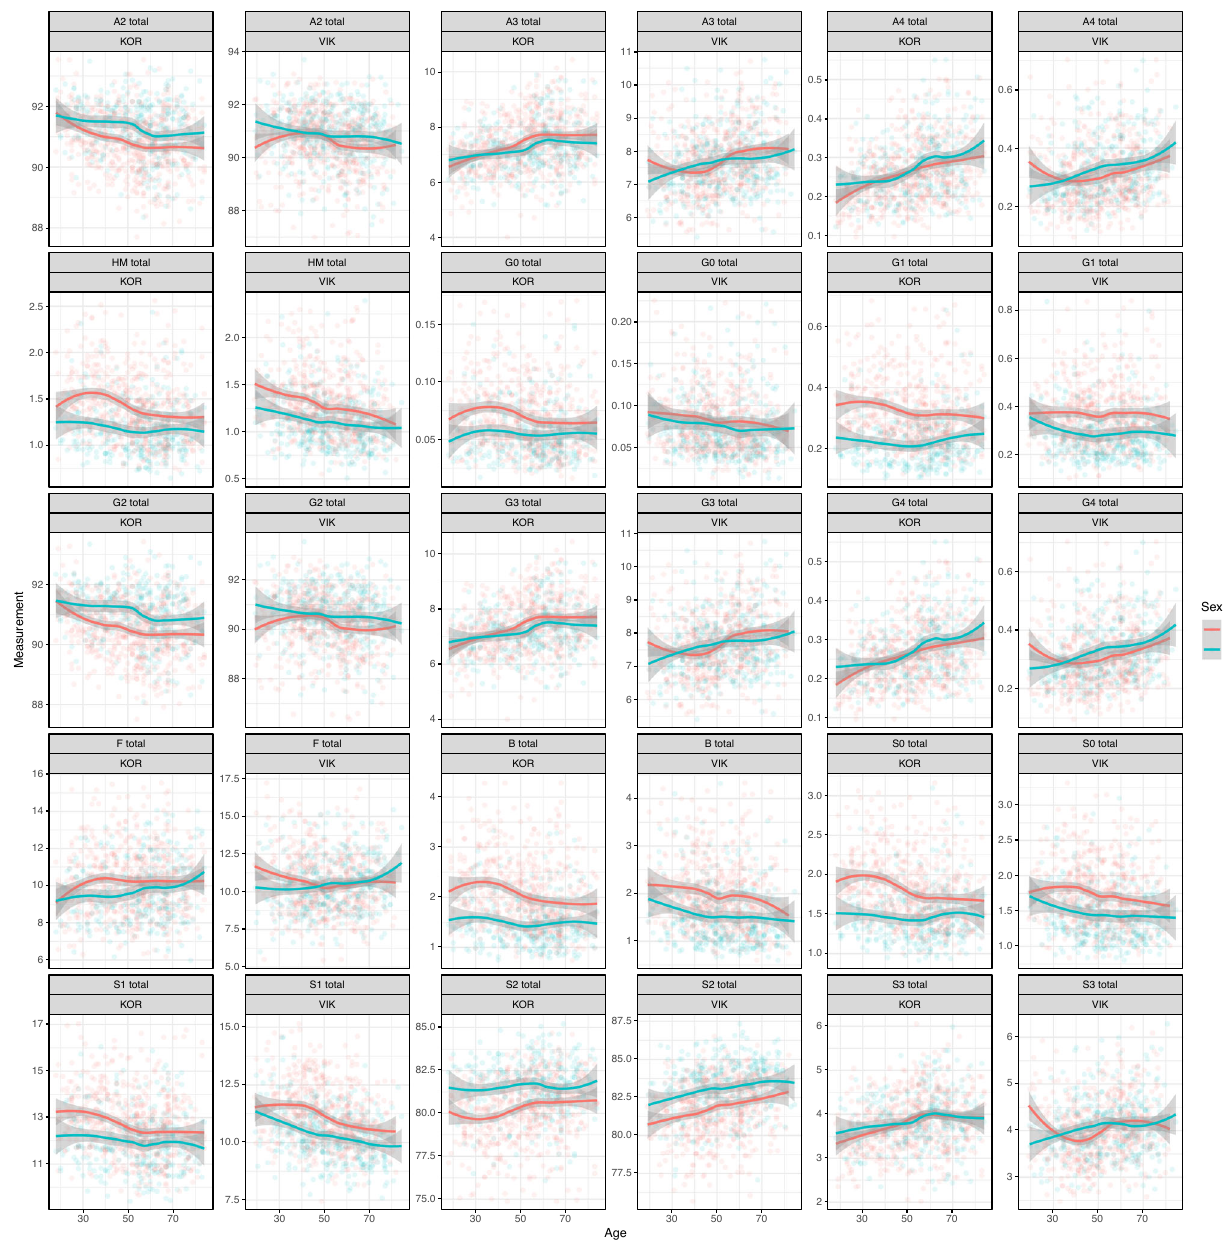
Fig. 3 N-glycosylation pro fi le of human plasma transferrin (Tf) is associated with age and sex. Derived N-glycosylation traits are shown for each cohort (KOR — Korcula, VIK — VIKING) and calculated according to formulas in Supplementary Table 4. Turquoise and red curves are fi tted local regression models describing a sex-speci fi c relationship between age and derived traits. The gray-shaded region is a pointwise 95% con fi dence interval on the fi tted values (there is 95% con fi dence that the true regression curve lies within the shaded region). F females, M males, A2 diantennary glycans, A3